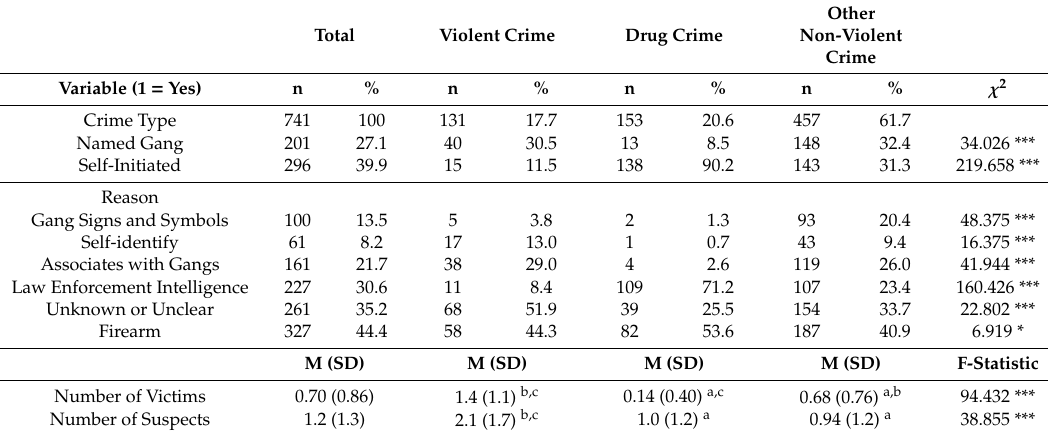
Table 2. Descriptive statistics for full sample and by dependent variable